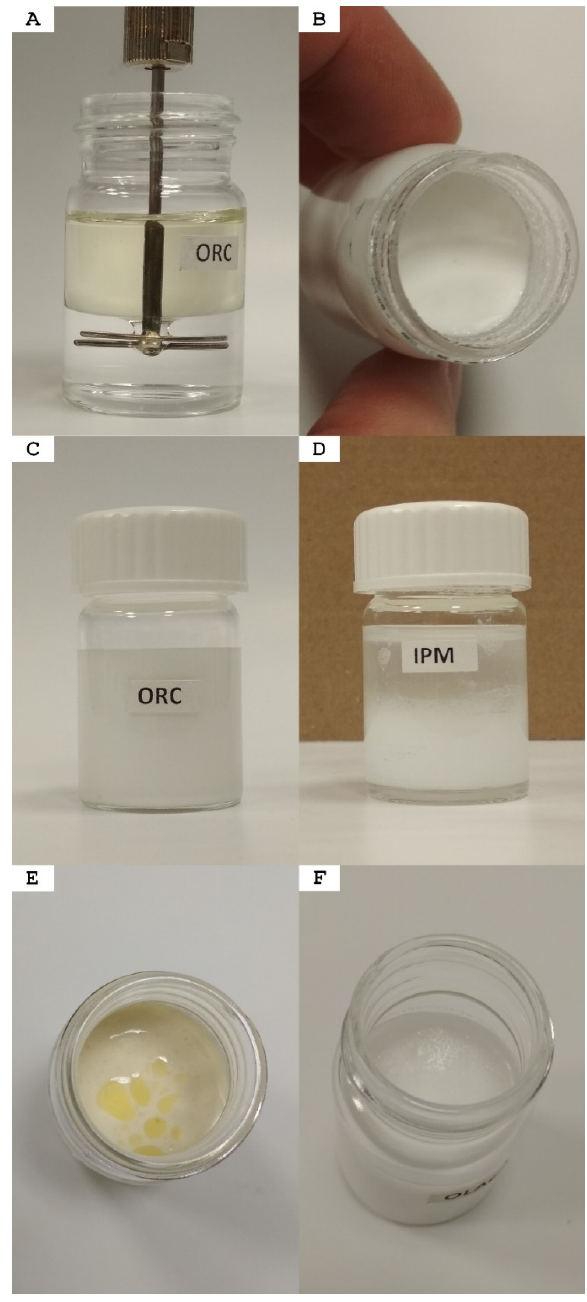
Figure 4. A brief look at the homogenisation process: ( A ) homogenisation setup; ( B ) usual